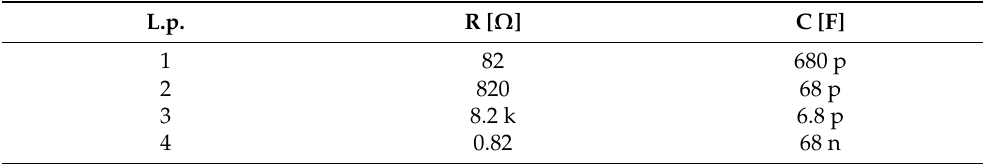
Table 2. RC network simulation iterations of input